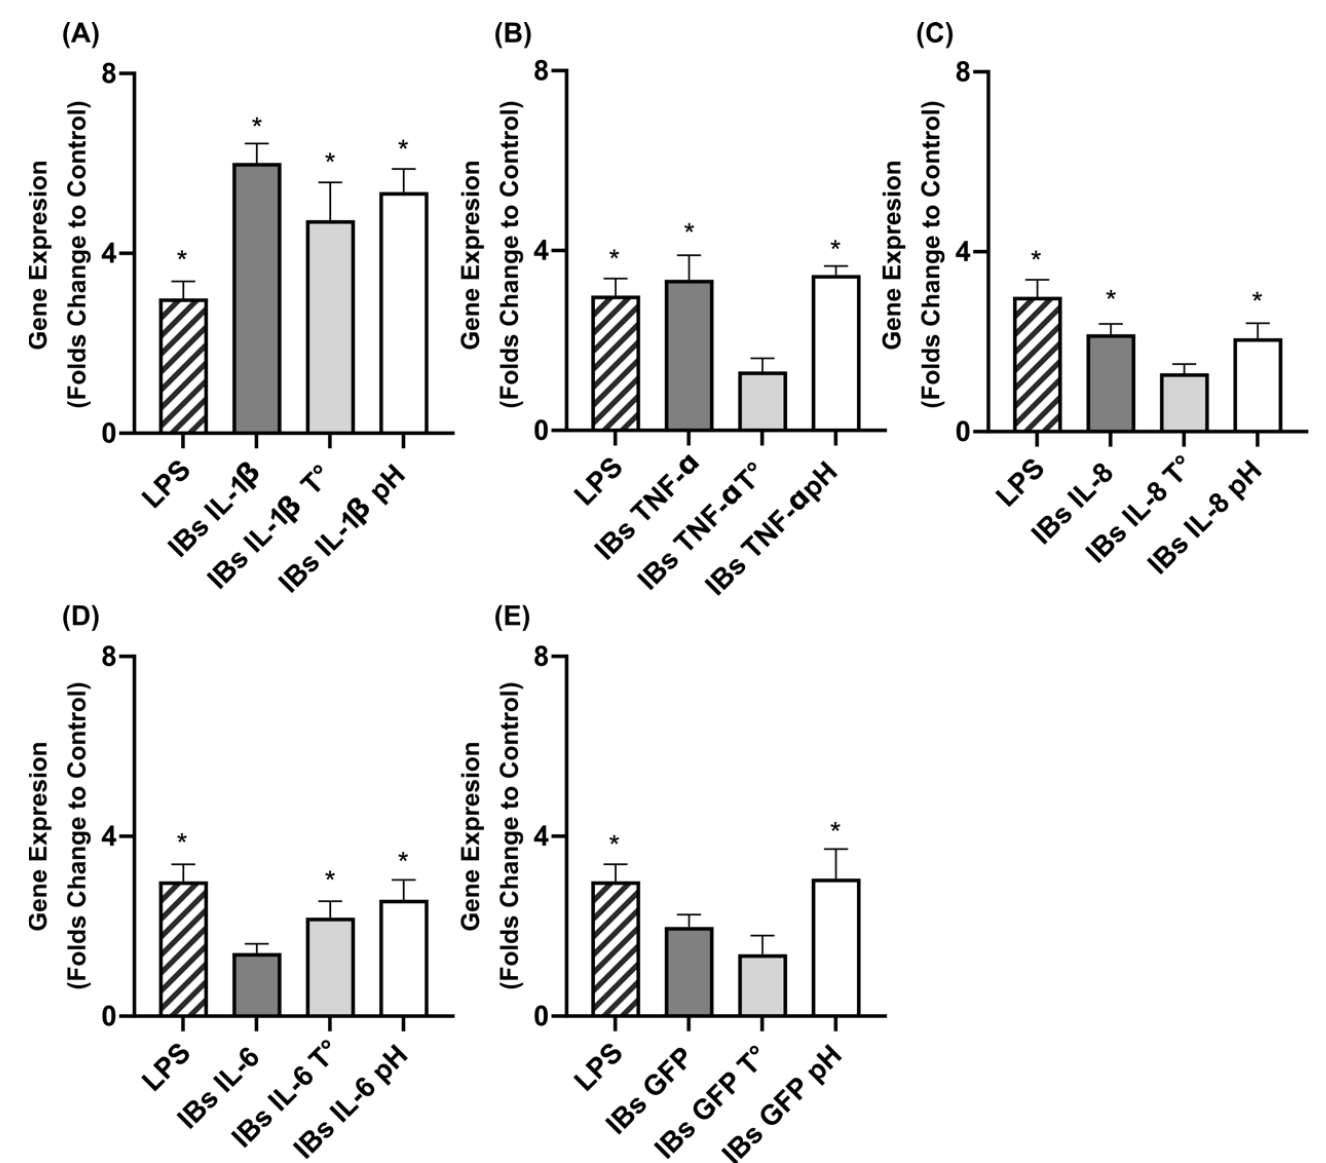
Figure 3. TNF- α gene expression (in folds compared to negative control) after temperature and pH stability assay in IPEC-J2 cells treated by ( A ) IL-1 β -, ( B ) TNF- α -, ( C ) IL-8-, ( D ) IL-6-, and ( E ) GFP-based nanoparticles. The bars of mean standard deviation and SEM of nontransformed data are represented. Asterisks display statistically significant differences in expression folds between PBS and treatments. ( A ) p = 0.0001; ( B ) p = 0.0001; ( C ) p = 0.0003; ( D ) p = 0.0002; ( E ) p = 0.0019 .